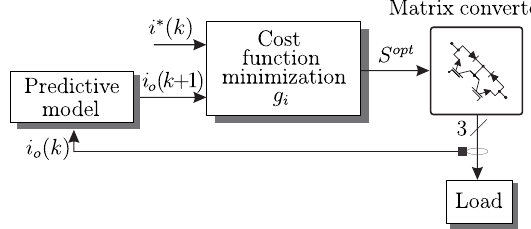
Figure 4. Predictive current control block